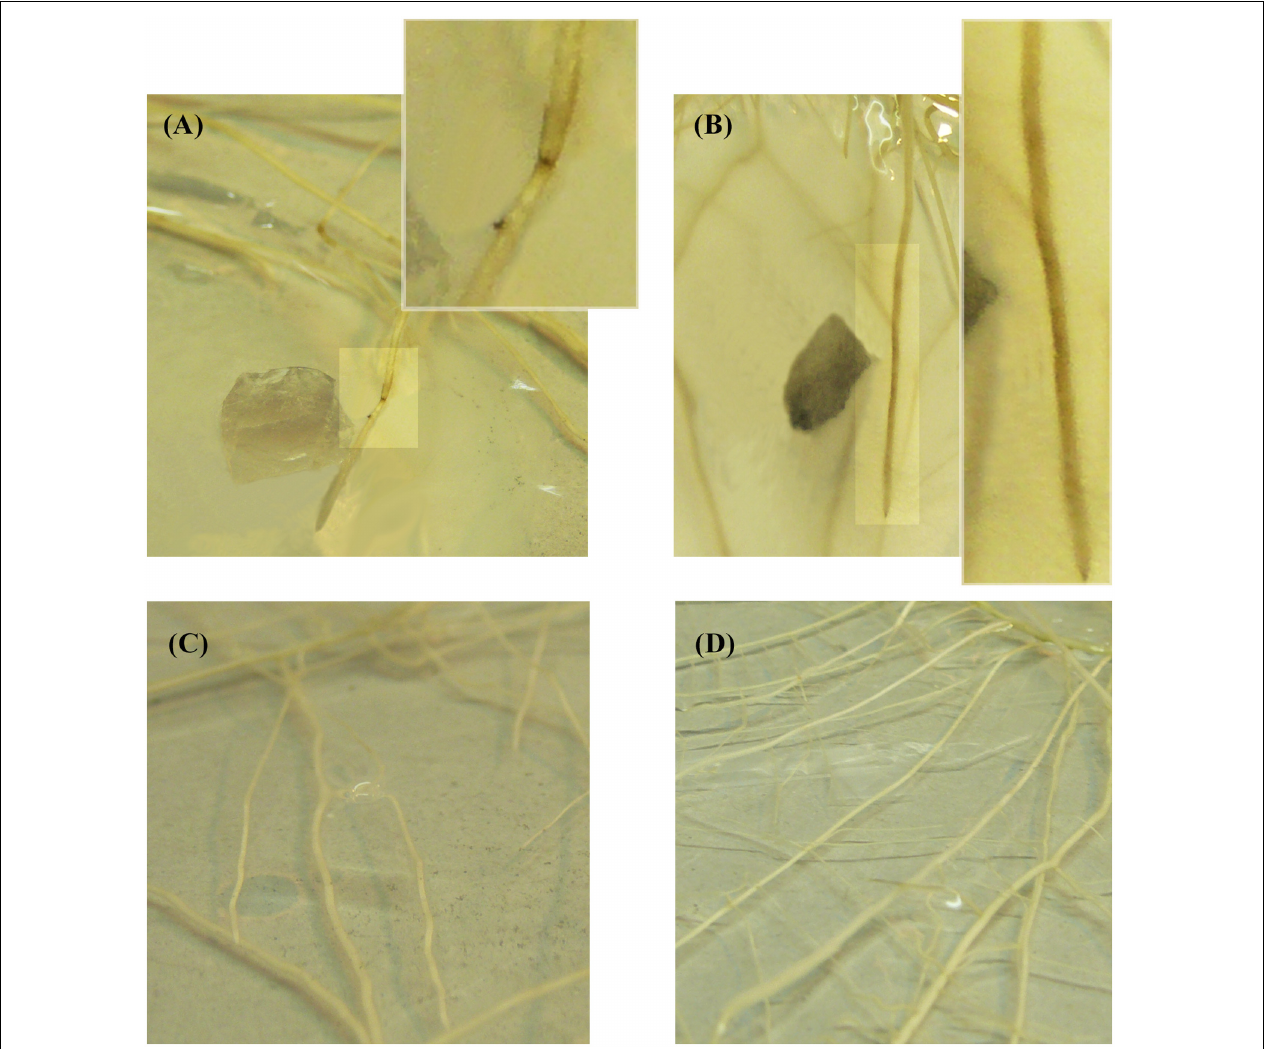
FIGURE 3 | Roots from soybean plantlets cultivated in vitro in modified Strullu-Romand (MSR) medium observed by naked eyes. (A) pre-mycorrhized soybean plantlets inoculated with a plug of PDA (25 mm 2 ) covered by F. virguliforme (+AMF+Fv). The white box shows an enlarged picture of root necrotic symptoms from A , 96 h following inoculation. (B) Non-mycorrhizal soybean plantlets inoculated with a plug of PDA (25 mm 2 ) covered by F. virguliforme . The white box shows an enlarged picture of root necrotic symptoms from B , 96 h following inoculation. (C) pre-mycorrhized soybean plantlets without F. virguliforme (+AMF − Fv). (D) Non-mycorrhizal soybean plantlets without F. virguliforme (–AMF −